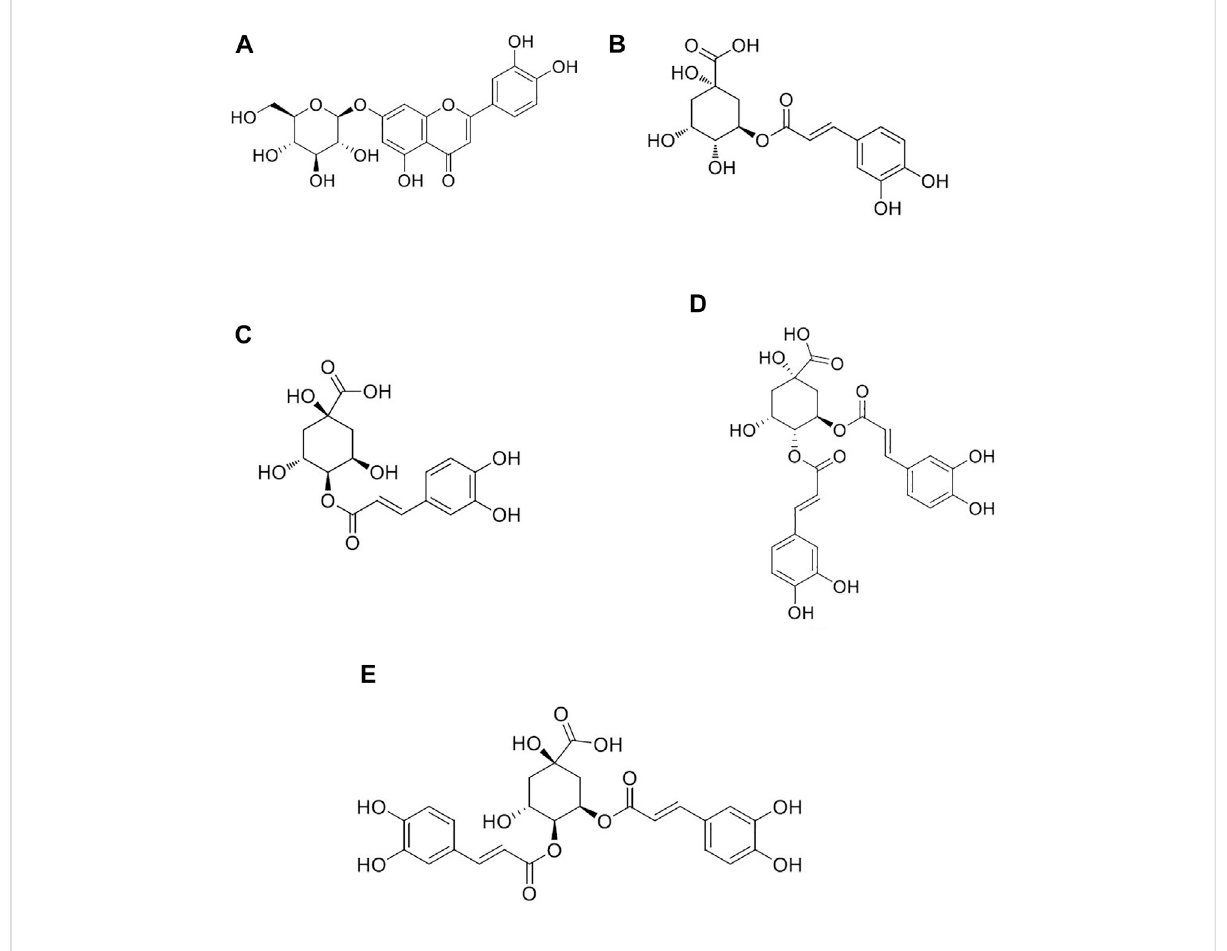
FIGURE 1 Chemical structures of luteolin (A) , chlorogenic acid (B) , cryptochlorogenic acid (C) , 3,4-dicaffeoylquinic acid (D) , and 4,5-dicaffeoylquinic acid (E)